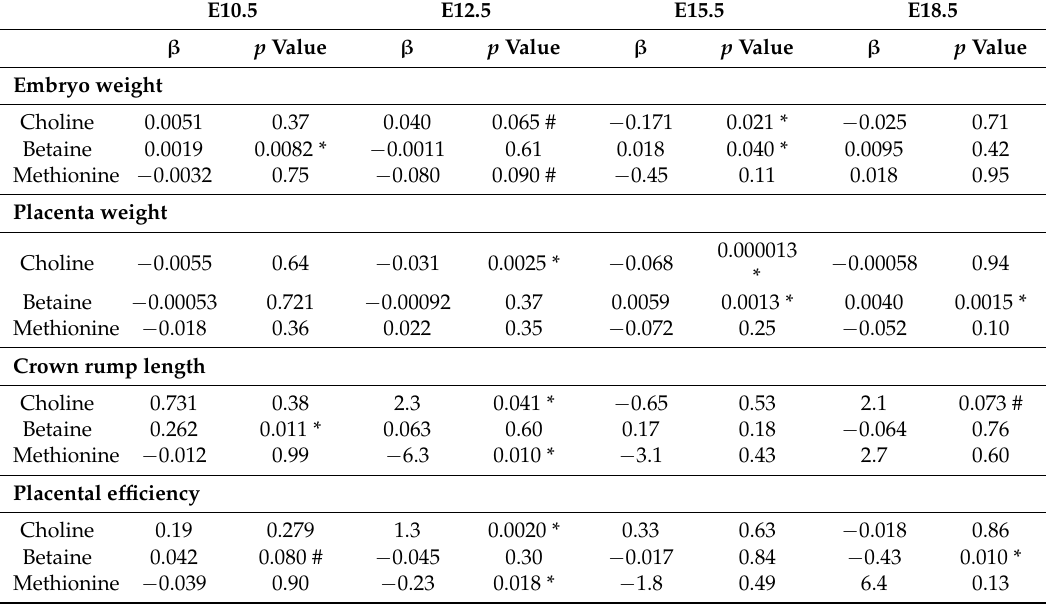
Table 3. Placental concentrations of choline metabolites as determinants of placental and fetal growth characteristics at E10.5, E12.5, E15.5, and E18.5. Data were analyzed using individual mixed linear models with metabolite, treatment, genotype, and sex as fixed effects and maternal ID as a random effect. # p < 0.1, * p ≤